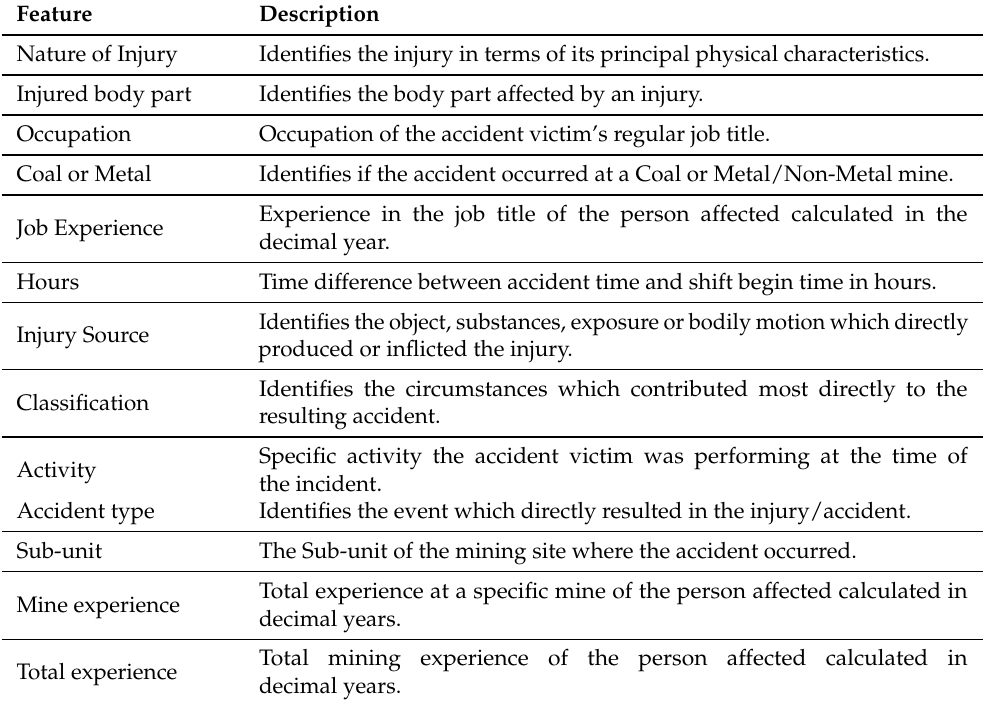
Table 5. Dependent variables and their description in descending order of their